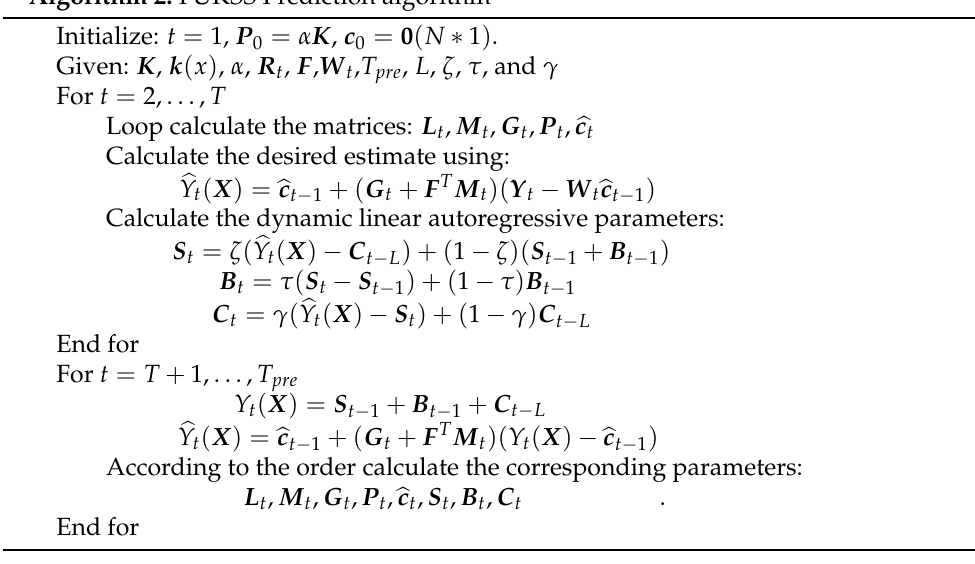
Algorithm 2: FUKSS Prediction